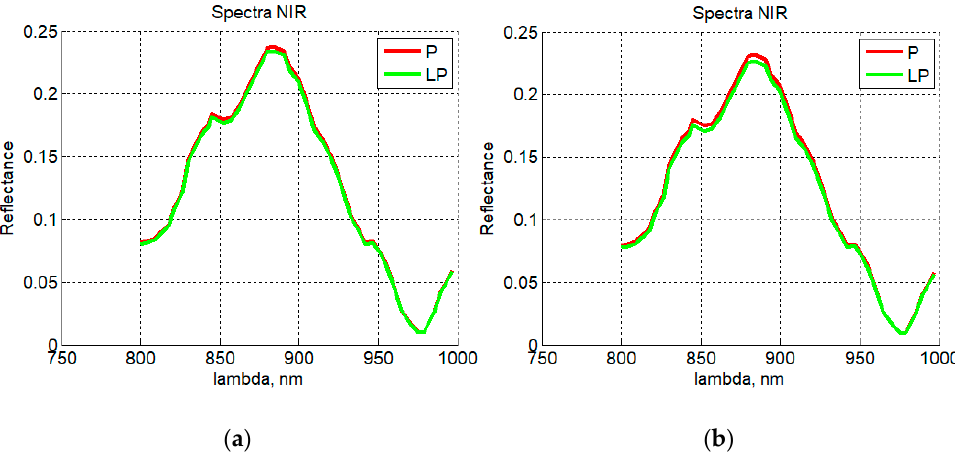
Figure 2. NIR spectral characteristics of mulberry leaves ( a ) adaxial part and ( b ) abaxial part.